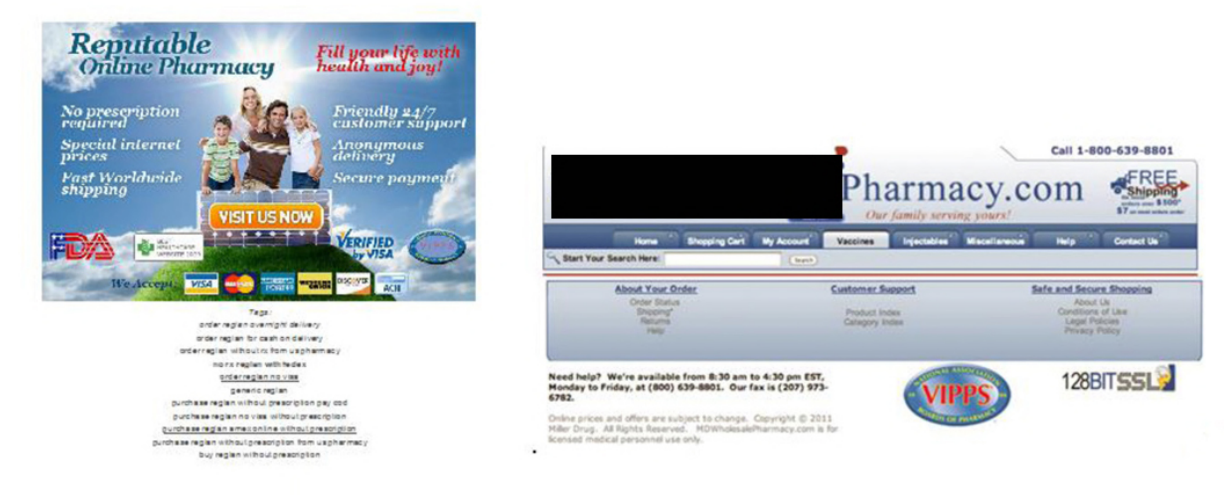
Figure 1. Unauthorized uses of Verified Internet Pharmacy Practice Sites (VIPPS)